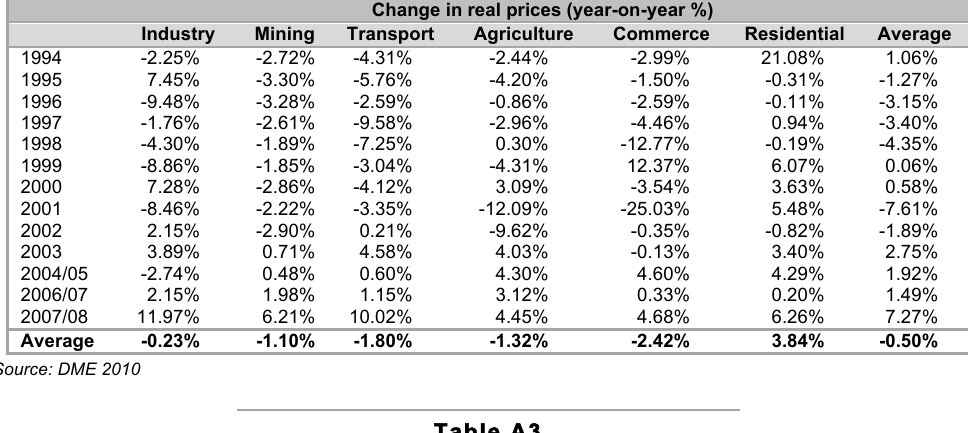
OLS regressions for each of the five studied